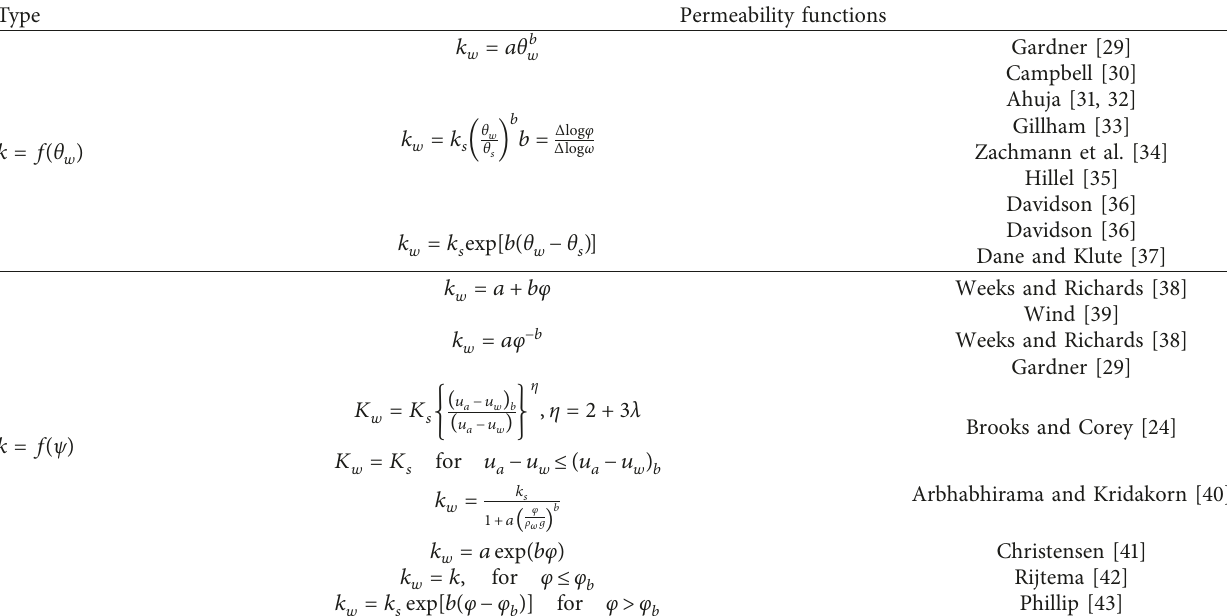
Table 1: Empirical permeability functions and soil-water characteristic and permeability coefficient curve equations.